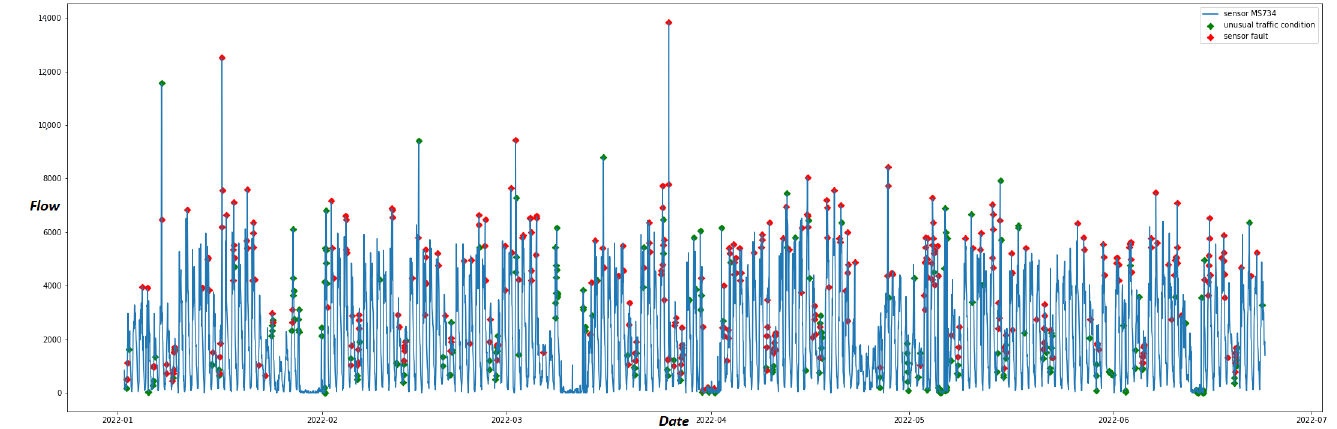
Figure 6. Time series of sensor “MS734” with anomalies detected by STL decomposition. Red dots are anomalies classified as “sensor faults”, and green dots are anomalies classified as “unusual traffic